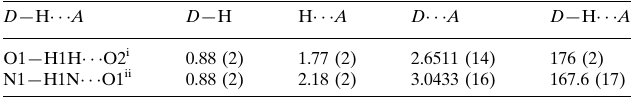
Hydrogen-bond geometry (A˚ , (cid:2)